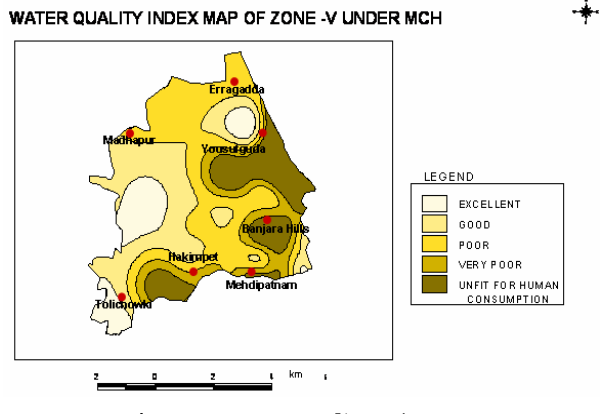
Figure 7: Water Quality Index